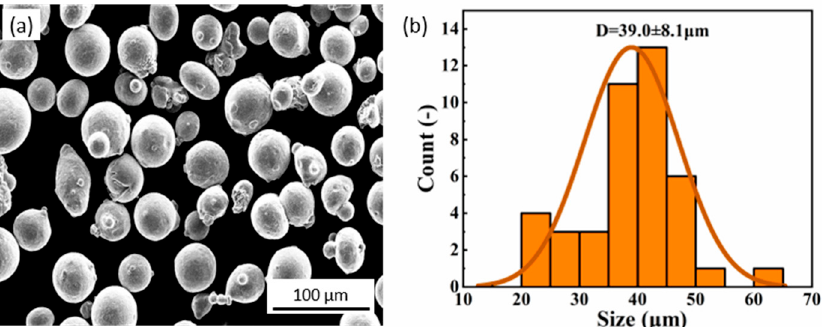
Figure 1. ( a ) SEM image and ( b ) size distribution of 316L stainless steel powders. Table 1. Chemical composition of the 316L stainless steel powder. Element